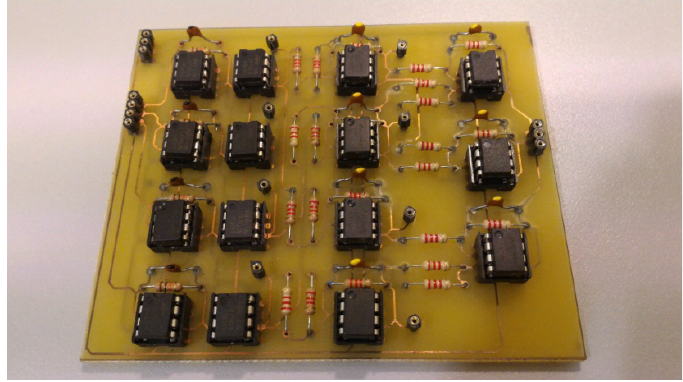
Figure 4. Printed circuit board of the signal conditioning module.